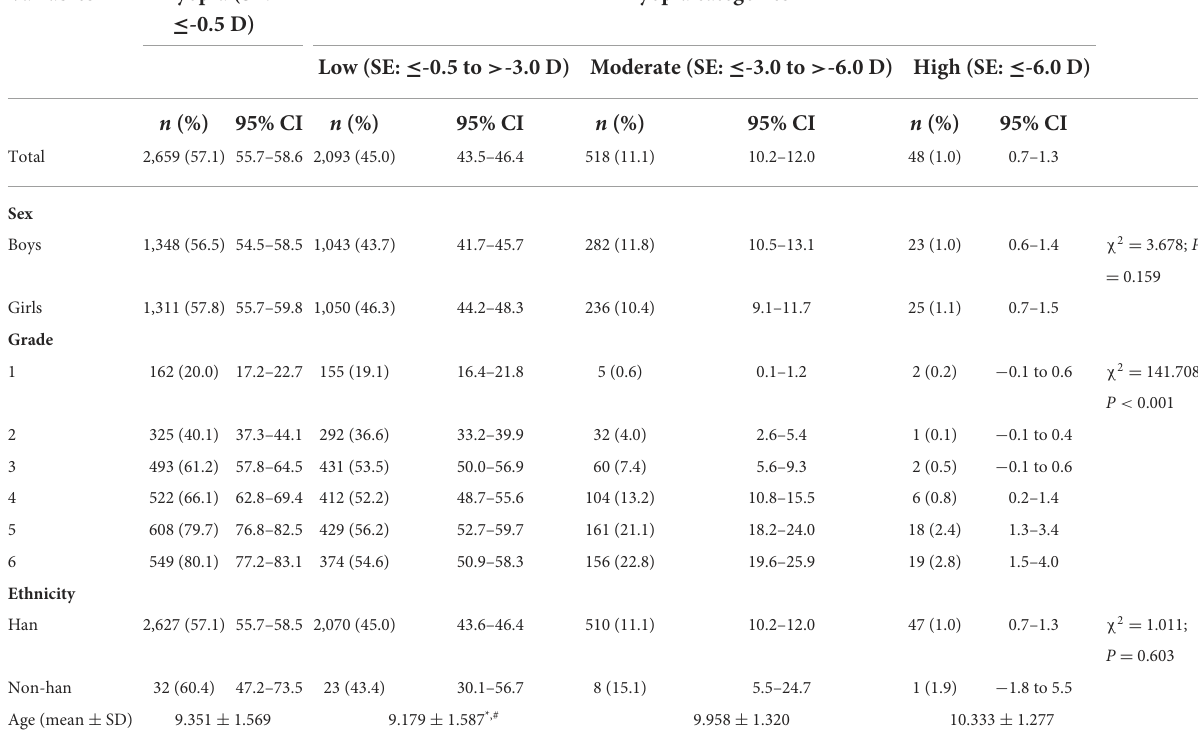
TABLE 2 Prevalence rate and categories of myopia stratified by age, sex, grade, and ethnicity. Variables